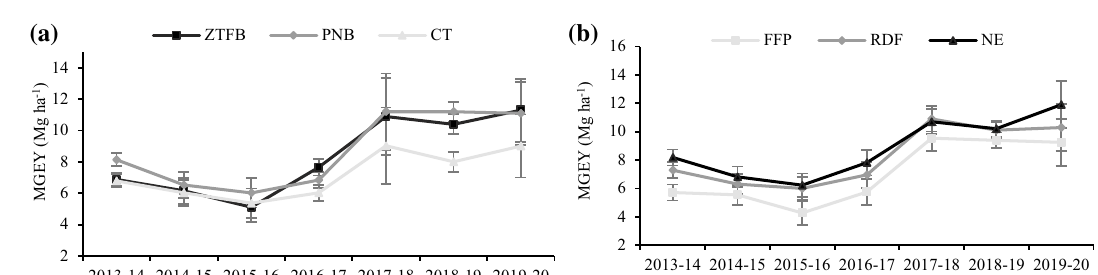
Figure 2. Seven years’ seed ( a , b ) and stover ( c , d ) yields trend of the chickpea under the CA-based CEP and nutrient management in the maize–chickpea rotation. The vertical bars indicate the LSD at p = 0.05.